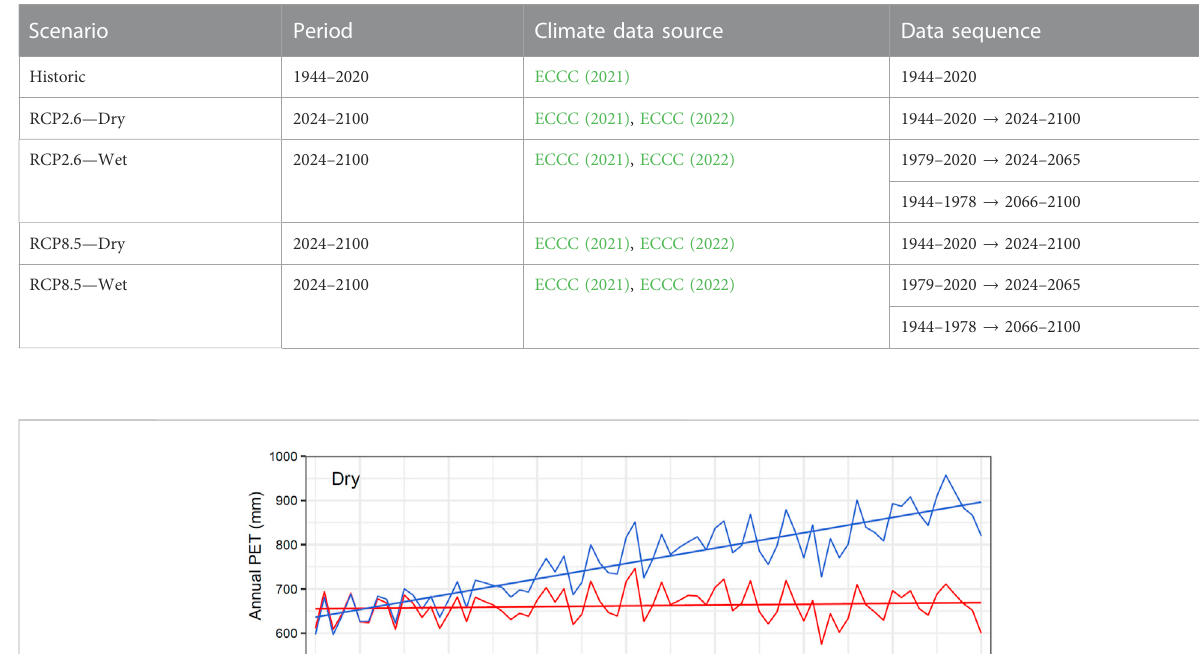
TABLE 2 Modeled climate scenario description.